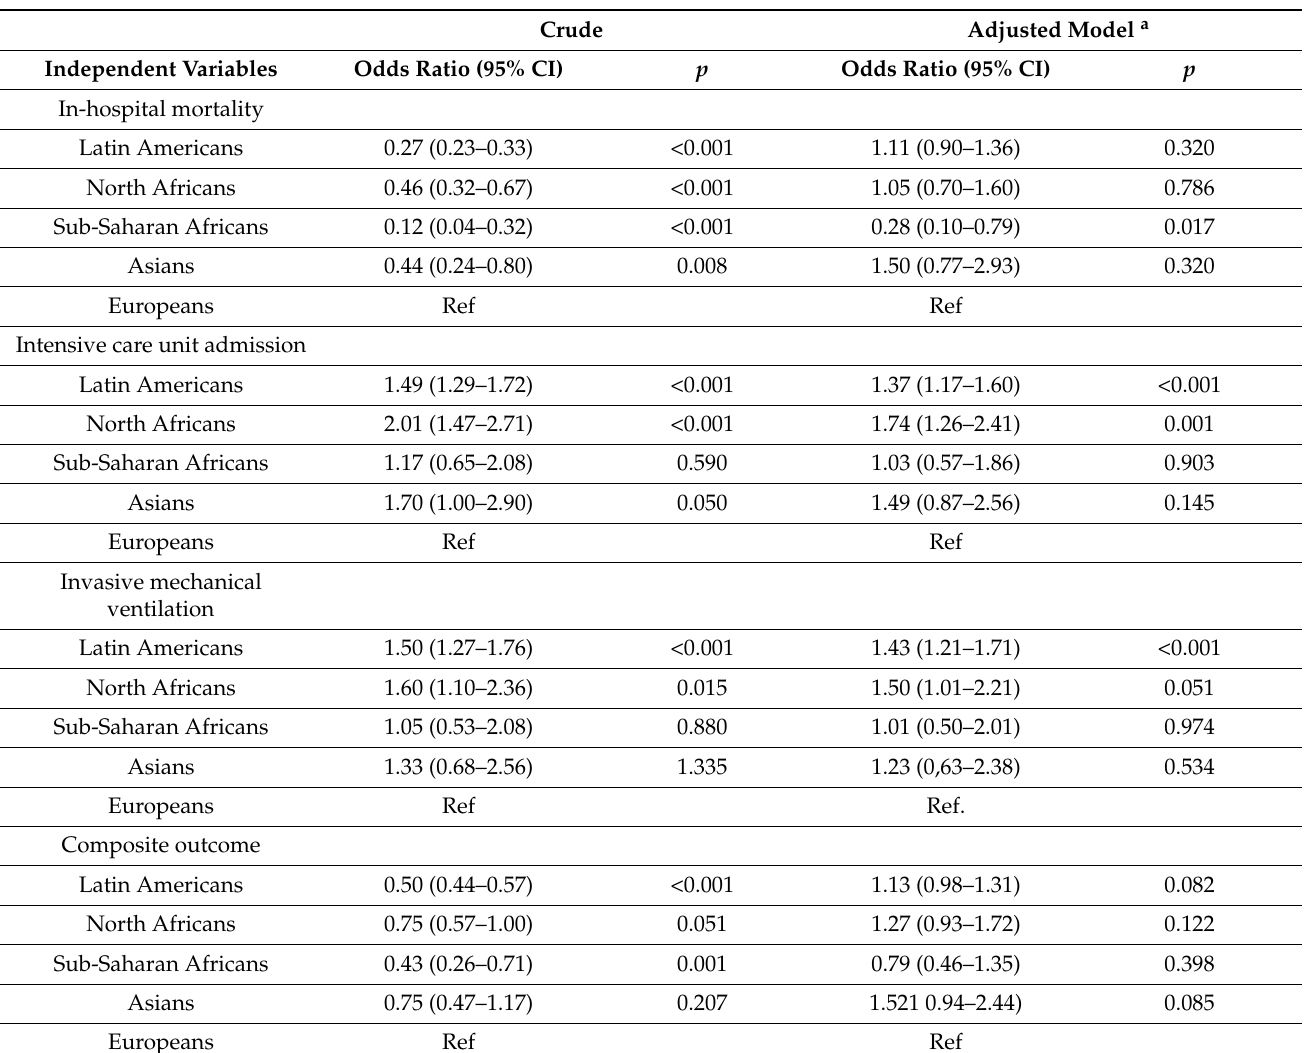
Table 3. Crude and multivariable logistic regression model for mortality, intensive care unit admission, and invasive mechanical ventilation among patients with confirmed COVID-19 by